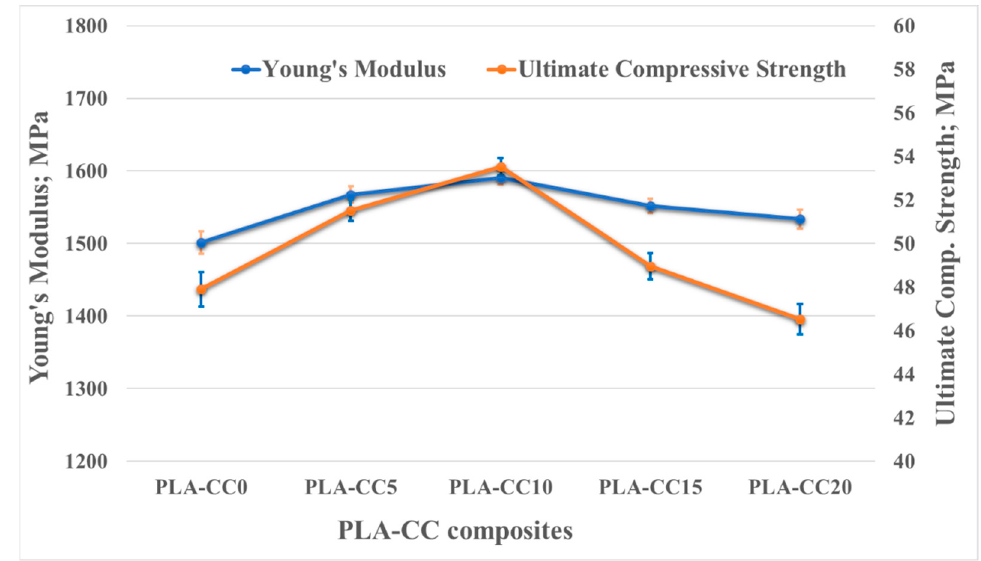
Figure 9. PLA-CC composites ultimate strength and Young’s mdulus for different corn cob weight fractions.